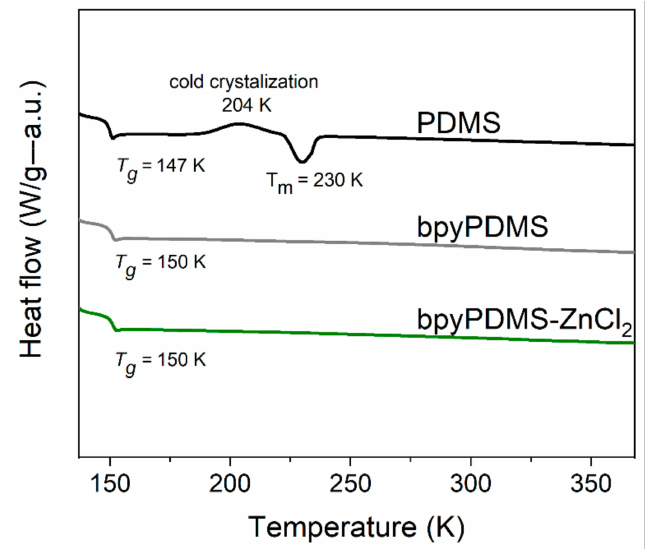
Figure 2. DSC thermograms of PDMS, bpyPDMS, and exemplary organometallic compound bpyPDMS-ZnCl 2 (thermograms are vertically shifted for better